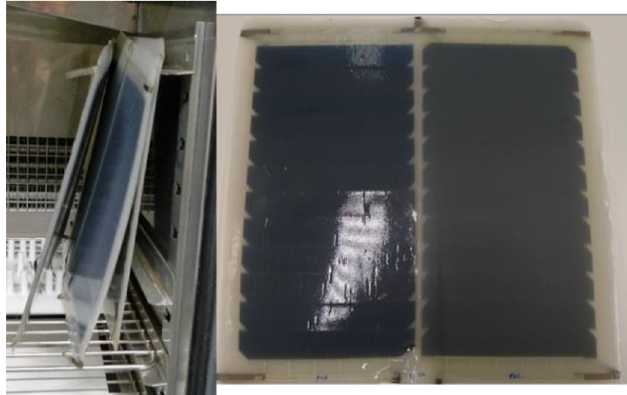
Fig. 7. Deformation of an “ encapsulant-reinforced ” laminate, due to vertical loading in damp heat conditions.